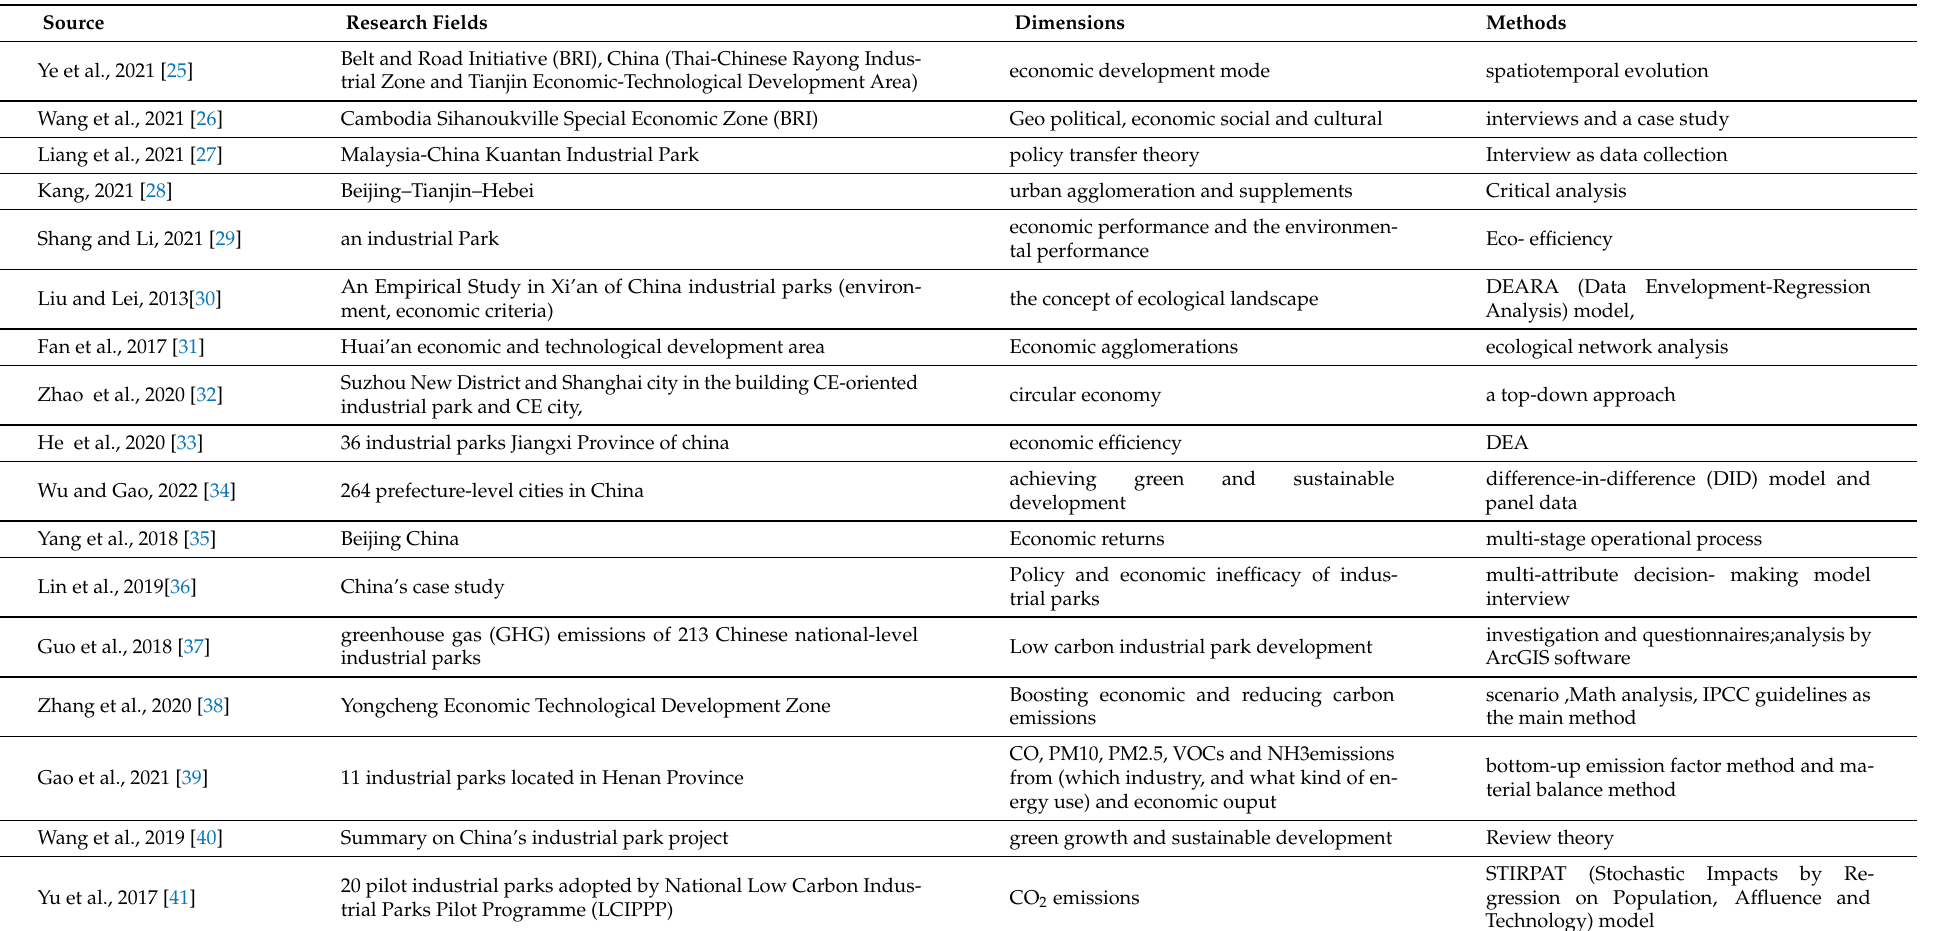
Table 1. Research fields (empirical analysis), dimensions, and methods from existing